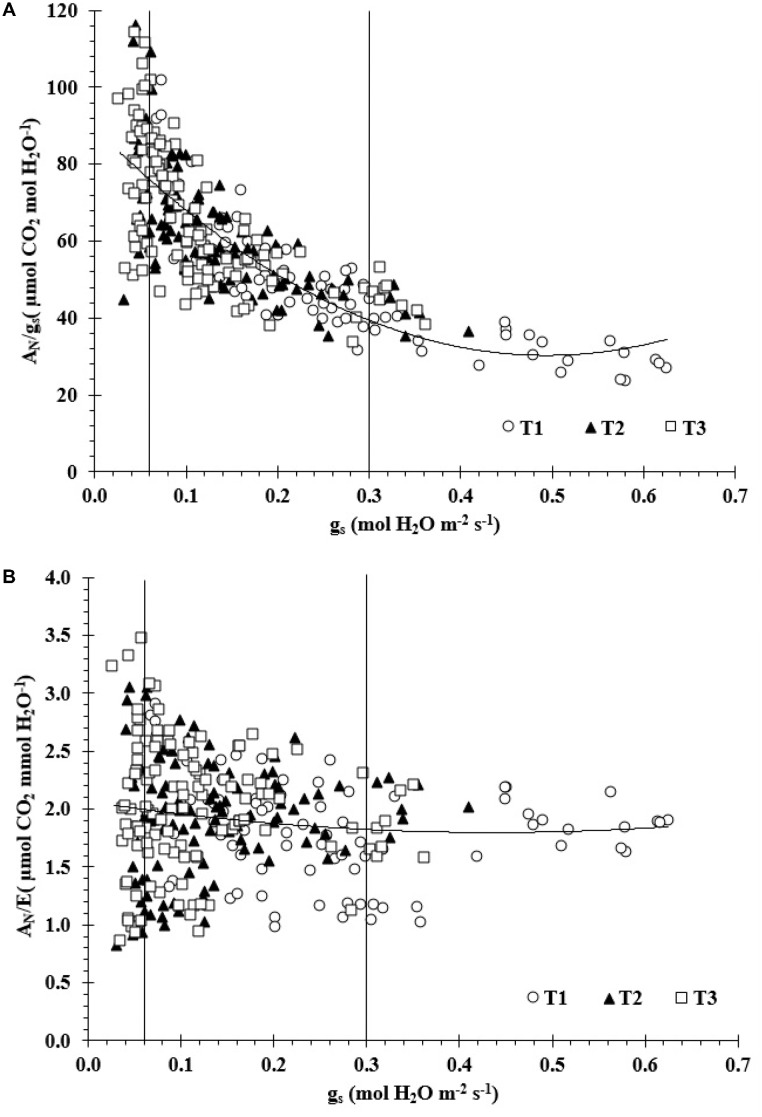
(A) The relationships between intrinsic water use efficiency versus stomatal conductance (gs) (AN/gs = 242.81gs2–239.68gs+89.497; R2 = 0.62) and (B) between water use efficiency versus gs (AN/E = 1.4086gs2–1.2237gs+2.0654; R2 = 0.02).